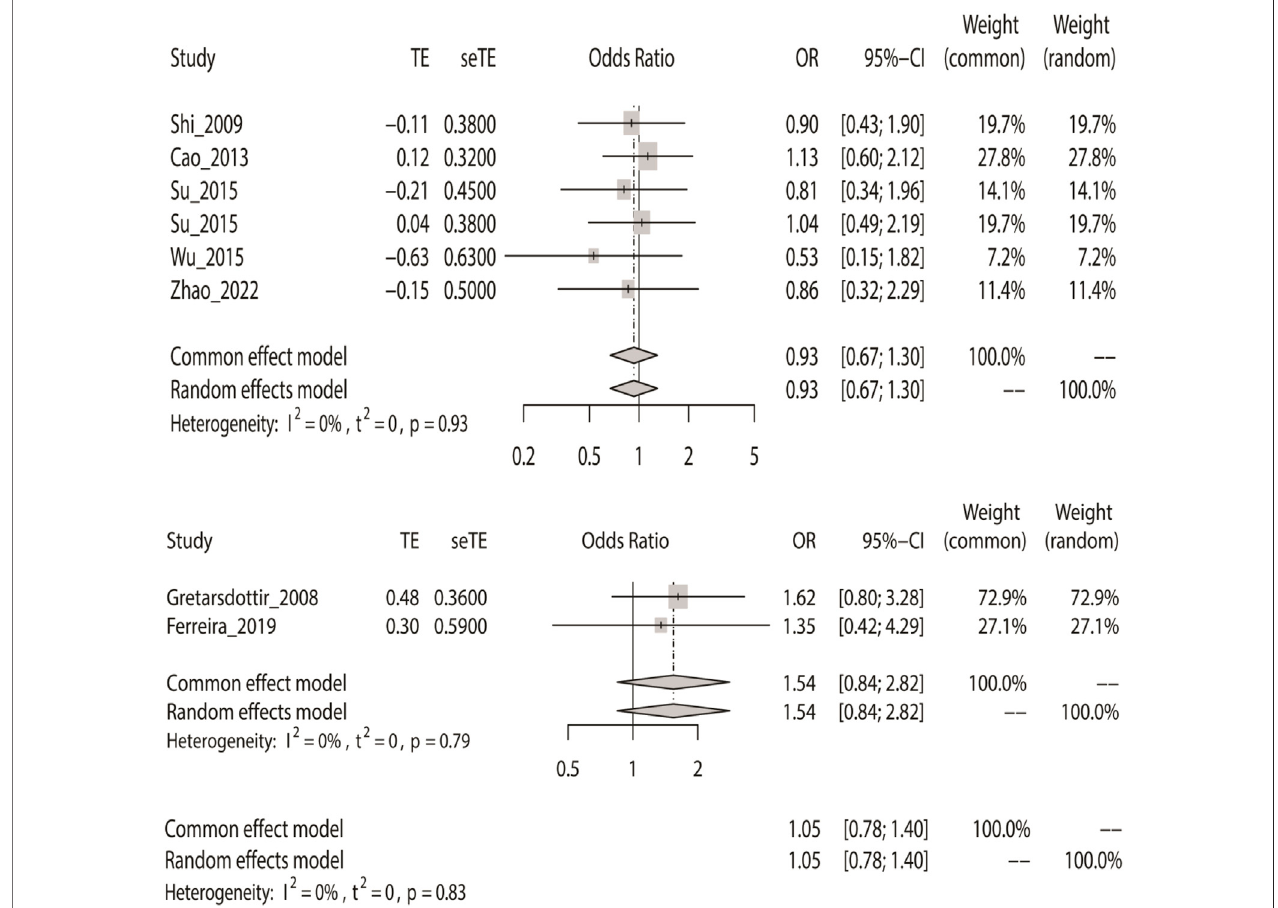
FIGURE 5 | Fixed-effect meta-analysis of the additive model for rs2200733 and rs6843082 in the Asian, non-Asian, and pooled populations.